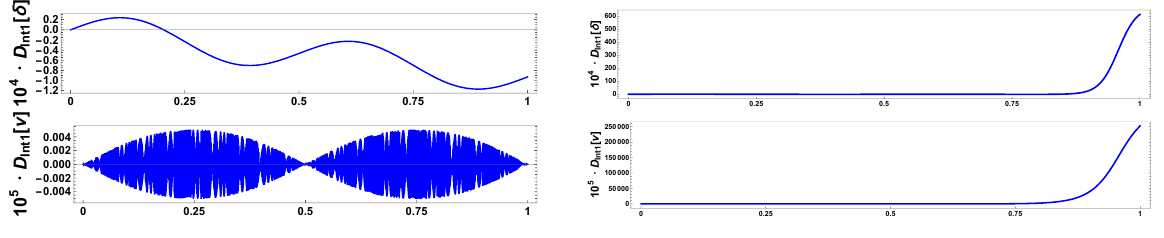
Fig. 2 Columns from left to right we have: (i) ρ = 0 , A 1 = 9 . 80 · 10 20 , A 2 = 9 . 8 · 10 20 , A 3 = 1 . 07 · 10 21 . (ii) ρ = 0 . 0005 , A 1 = 1 . 17 · 10 21 , A 2 = 1 . 23 · 10 21 , A 3 = 1 . 39 · 10 21 . Abscissas are orbital periods and D [ x ] = x Full − x Intermediary . The orbital period is 10.8 hours and r is expressed in Km, which initially is set to 1.560 Km.